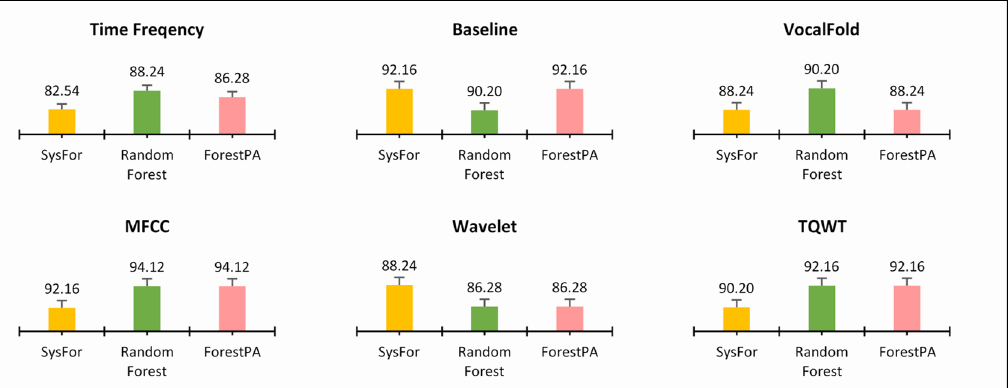
Figure 4. Highest detection accuracy of decision forest algorithms with minimum number of trees on various feature of Istanbul acoustic dataset.